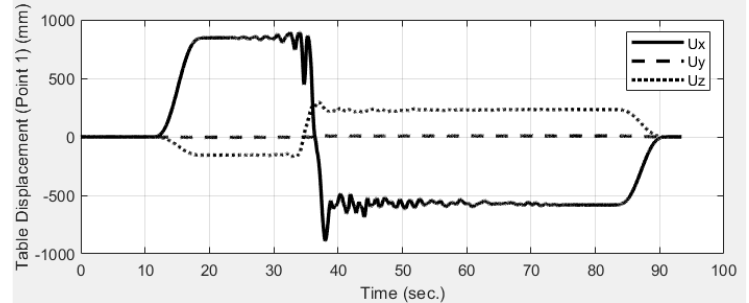
Figure 14. Table movement measured by image analysis. Shake table movement was estimated the image analysis.